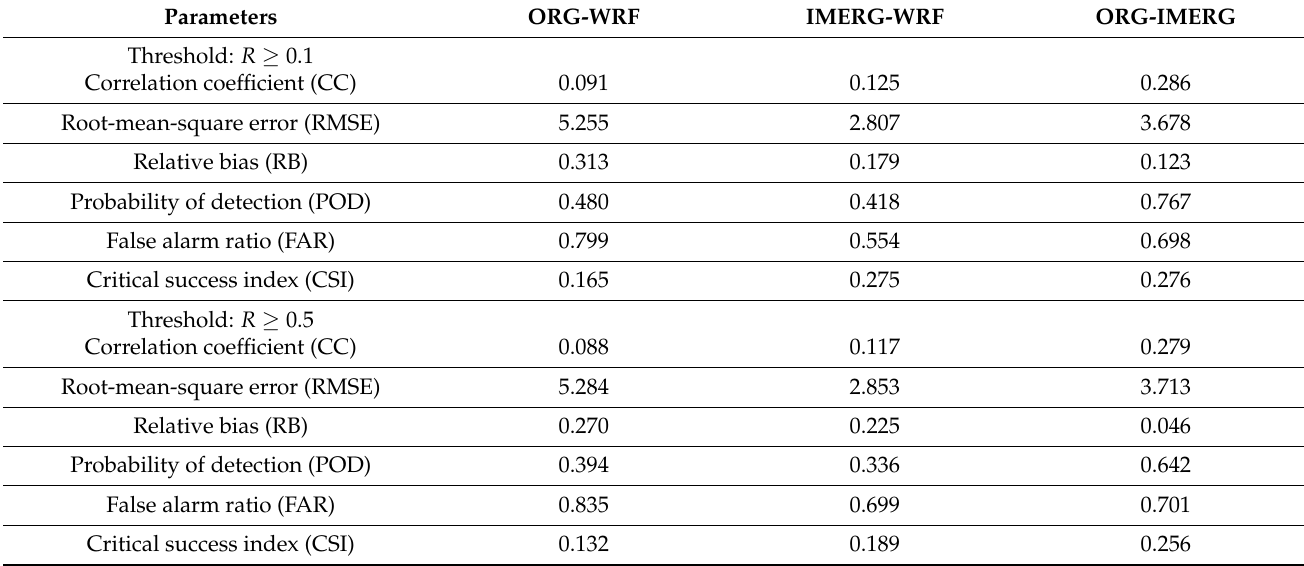
Figure 3. Spatial configuration of the domains used in the WRF simulations. Table 1. Evaluation metrics calculated for ORG, WRF, and IMERG-F data at Kototabang for two rainfall rate ( R )